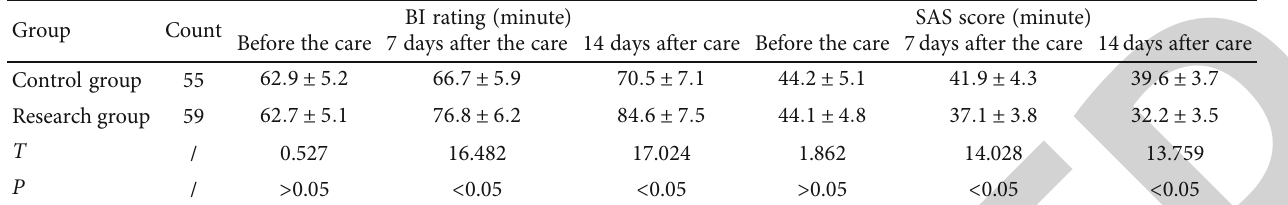
Table 1: Comparison of BI and SAS scores between the two groups ().